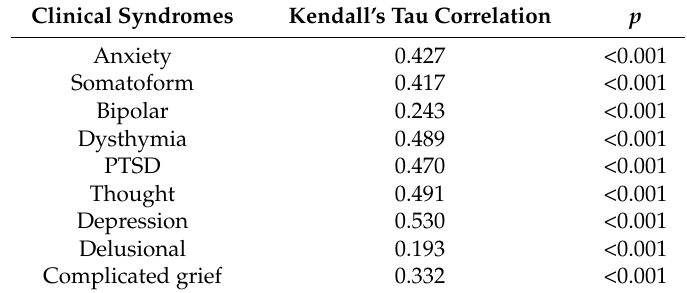
Table 2. Relationship between clinical syndromes and risk of suicide through Kendall’s tau correlation.